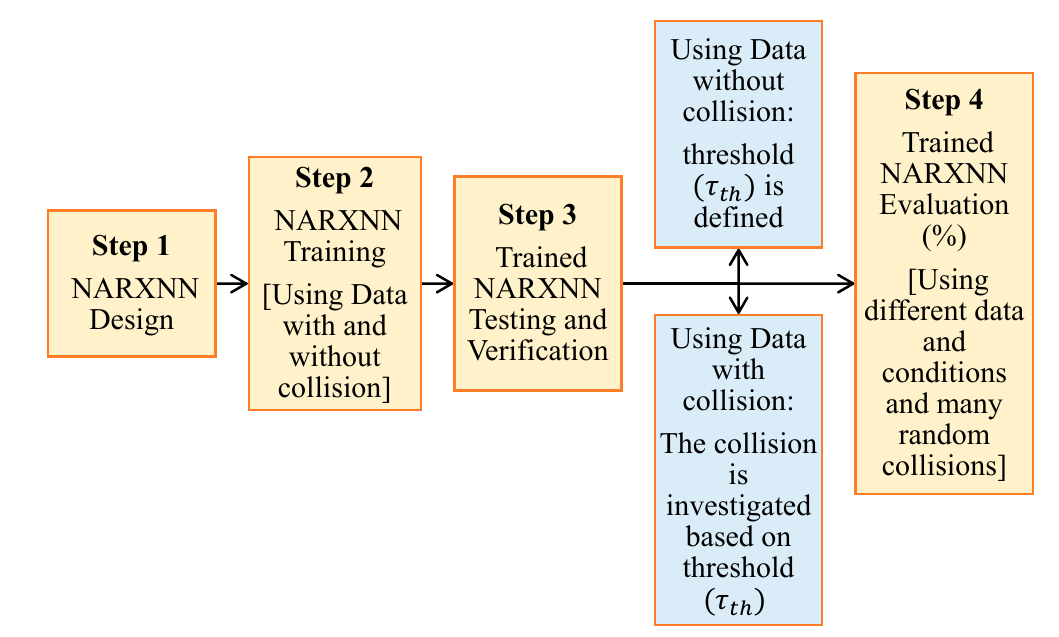
Figure 2. The followed steps and methodology with the proposed NARXNN.